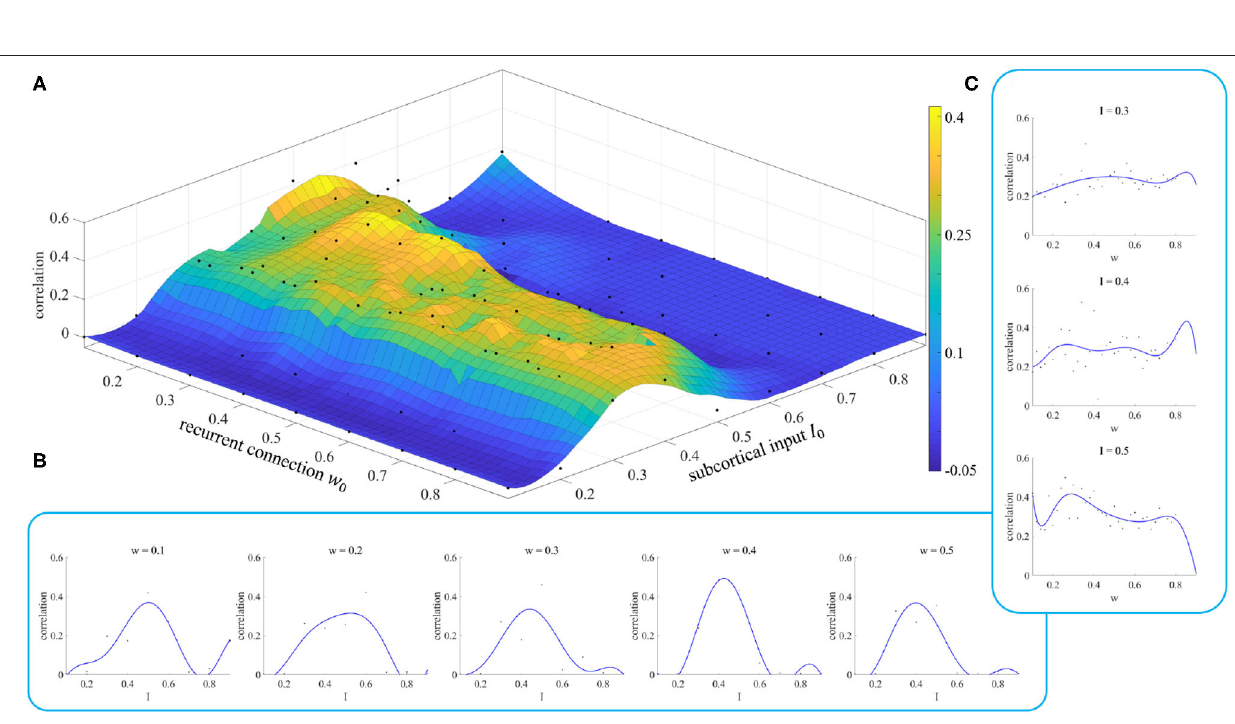
Frontiers in Aging Neuroscience |